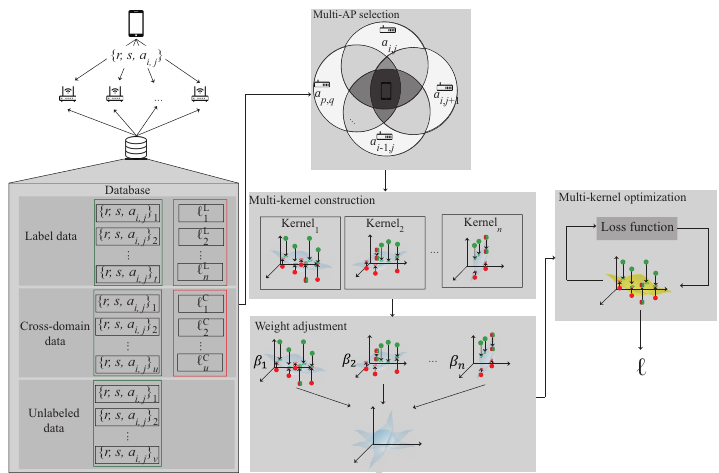
Figure 1. System